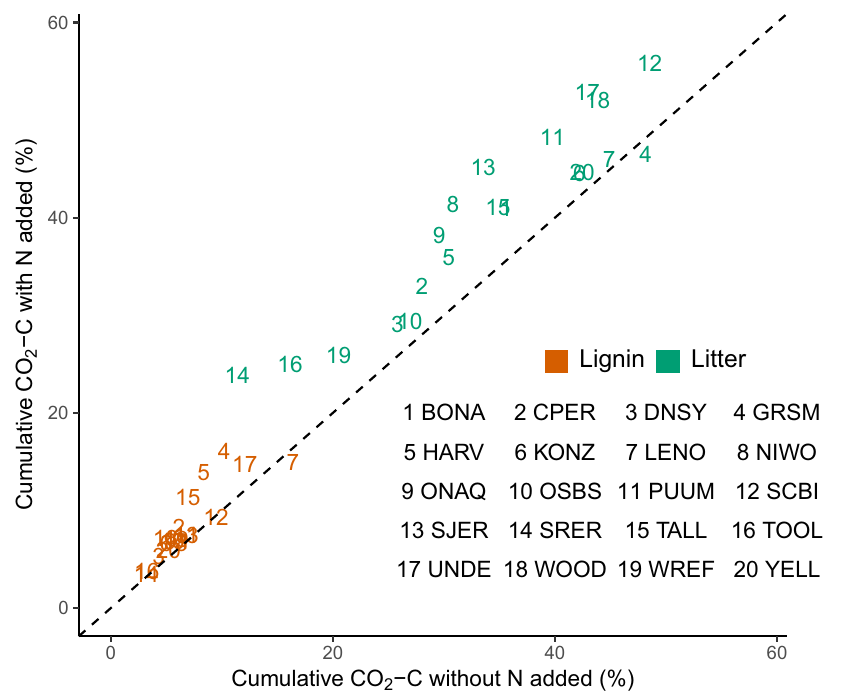
Fig.3|Effectsofnitrogen(N)additiononcumulativedecomposition(CO 2 -C)of lignin and litter incubated in the lab over 18 months, averaged from four sampling points at 0 – 15cm depth from 20 NEON sites. The decomposition is expressed asa percentage of the initial C mass in each pool.Numbers correspond